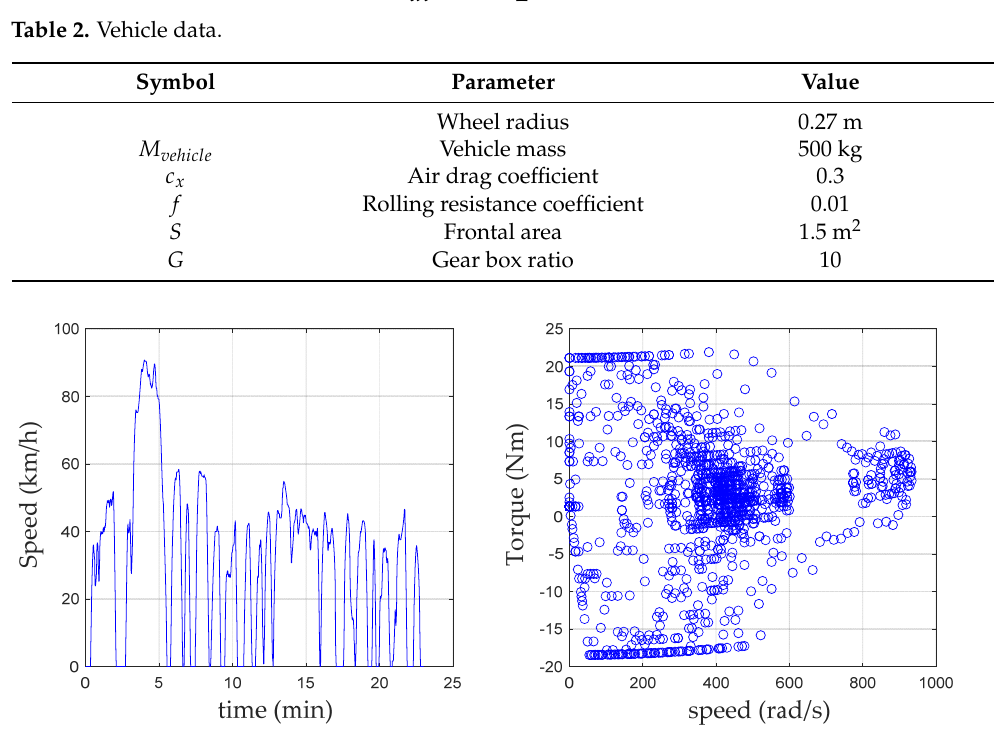
Table 2. Vehicle data.